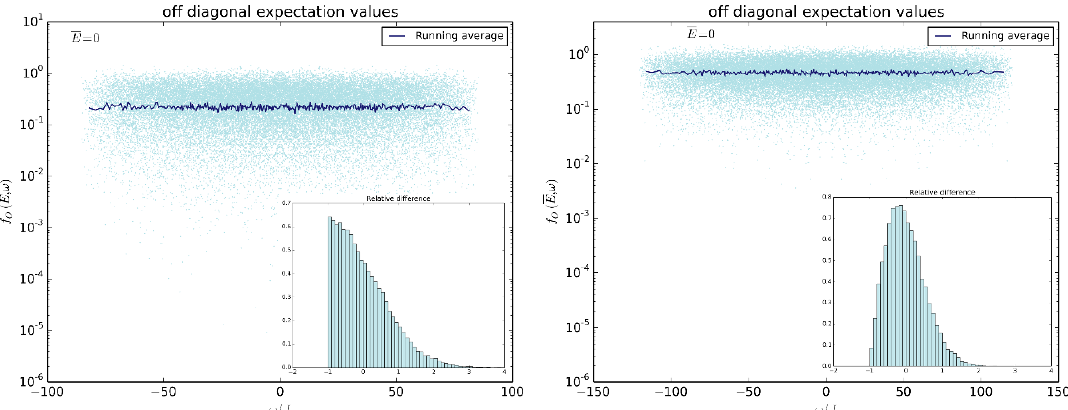
Figure 10 . O(cid:11)-diagonal values of matrix elements O nm = jh n jOj m ij for a randomly chosen opera- tor O in random matrix theory (a GOE matrix on the left and a GUE matrix on the right) averaged over 1000 realizations. The inset shows a histogram of relative di(cid:11)erences between raw data and running average (within a selected energy window). Left panel: the function f O ( (cid:22) E; ! ) (we show the running average in dark blue and the raw data in light blue) in the GOE for Hilbert space dimen- sion dim( H ) = 2 12 . One clearly sees the constancy of f O ( (cid:22) E; ! ) in RMT. Right panel: the function f O ( (cid:22) E; ! ) (we show the running average in dark blue and the raw data in light blue) in the GOE for Hilbert space dimension dim( H ) = 2 12 . One clearly sees the constancy of f O ( (cid:22) E; ! ) in RMT.